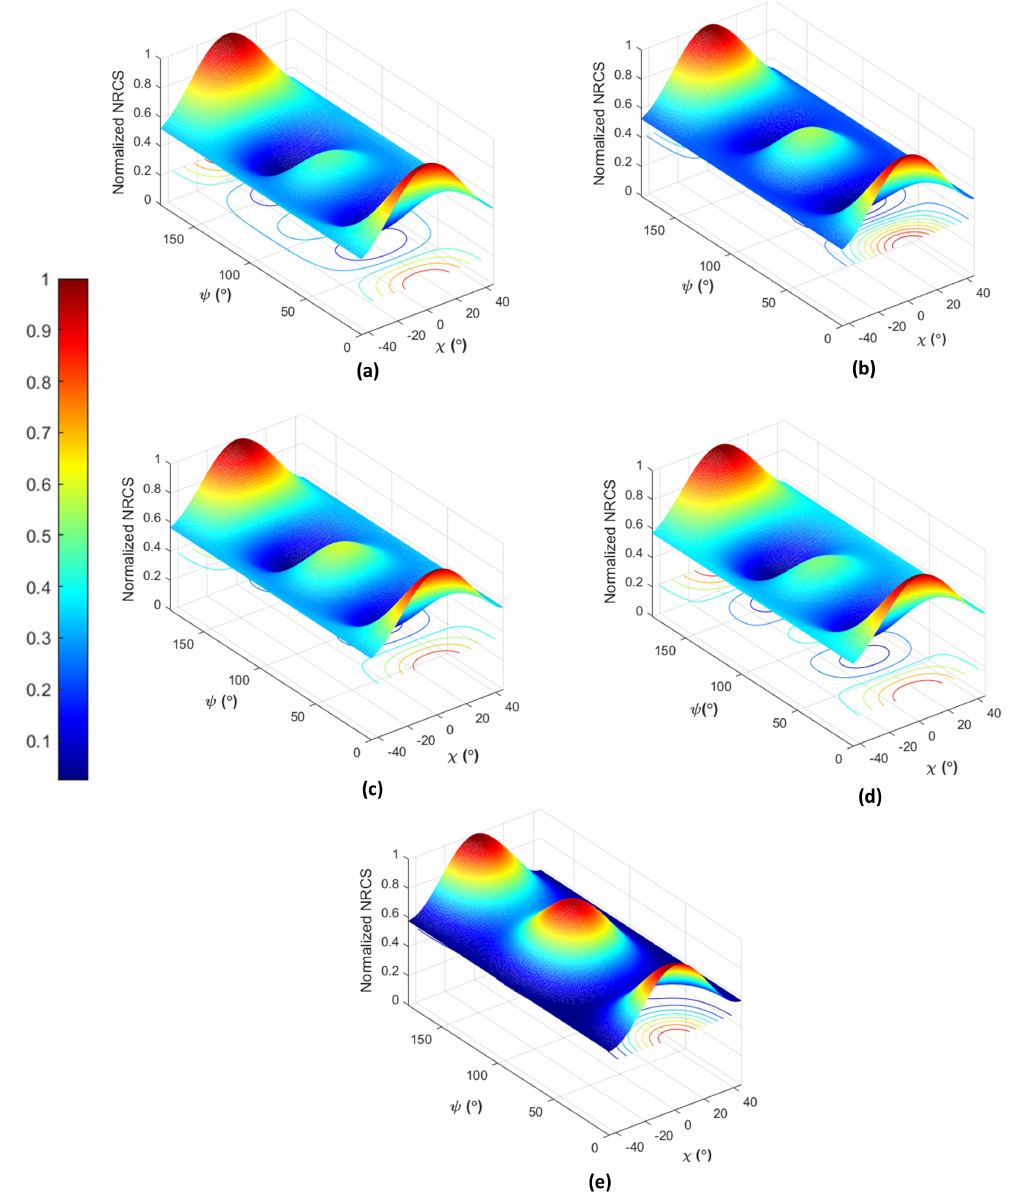
Figure 12. Normalised co–polarisation signature evaluated over the fishing trawler ROI at: ( a ) AOI = 35.7 ◦ , ( b ) AOI = 38.5 ◦ , ( c ) AOI = 41.5 ◦ , ( d ) AOI = 45 ◦ , and ( e ) AOI = 48.3 ◦